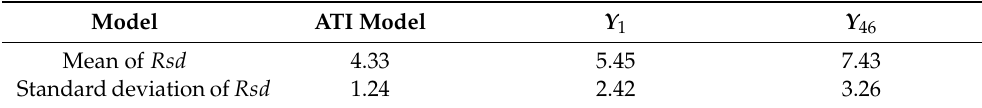
Table 6. Prediction results of the three models (Unit: μ m).